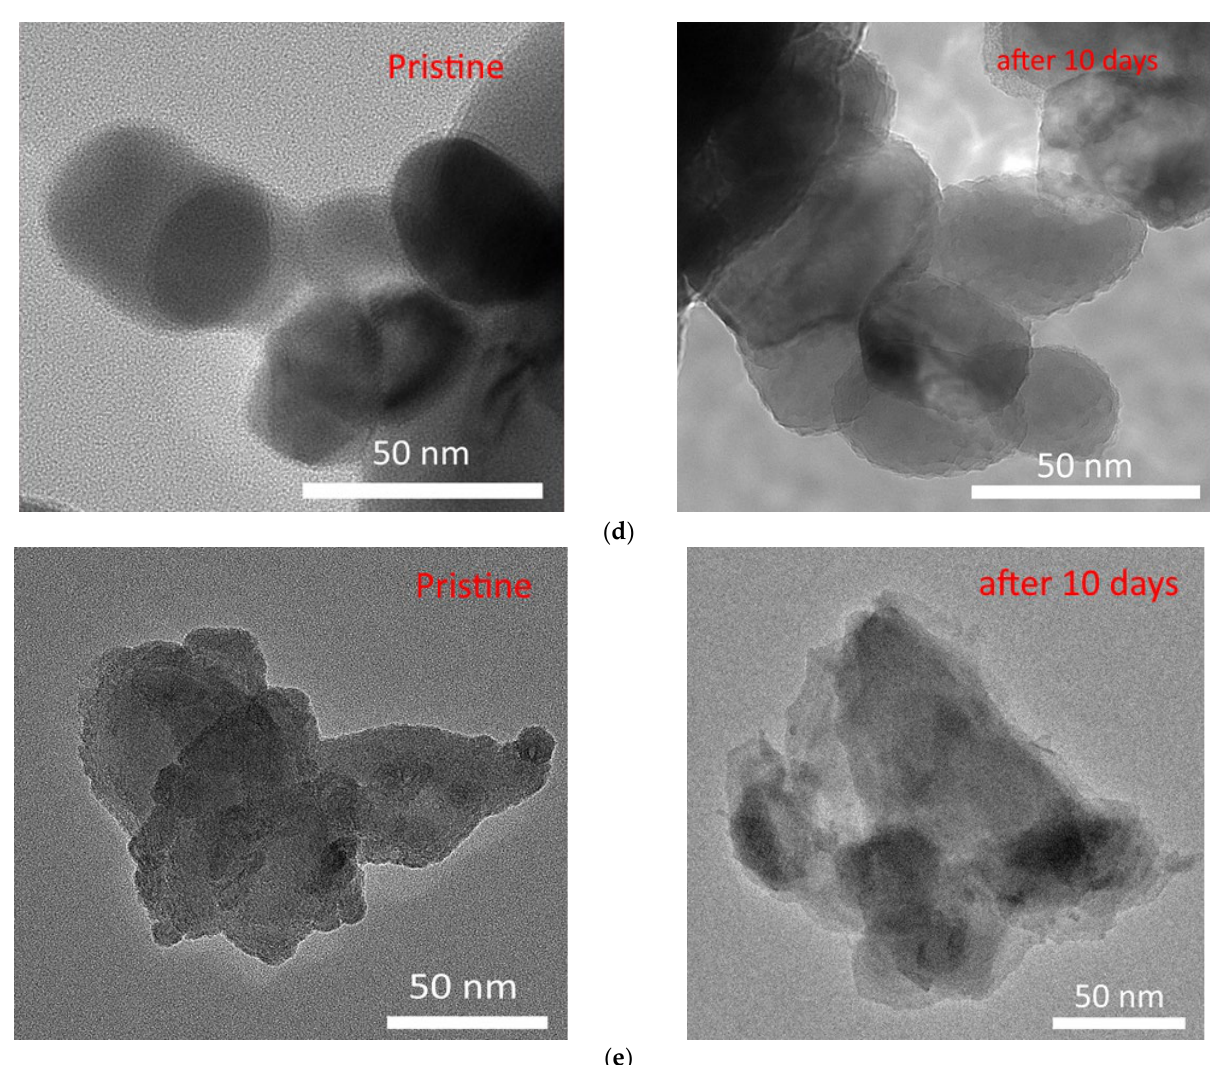
Figure 10. TEM images of the dynamics of changes in the morphological features of the studied nanocomposites before and after corrosion in a model solution: ( a ) Fe 2 O 3 nanoparticles; ( b ) Fe 2 O 3 @GdFeO 3 nanoparticles; ( c ) Fe 2 O 3 @NdFeO 3 nanoparticles; ( d ) CeFeO 3 nanoparticles; ( e ) YFeO 3 nanoparticles CeFeO 3